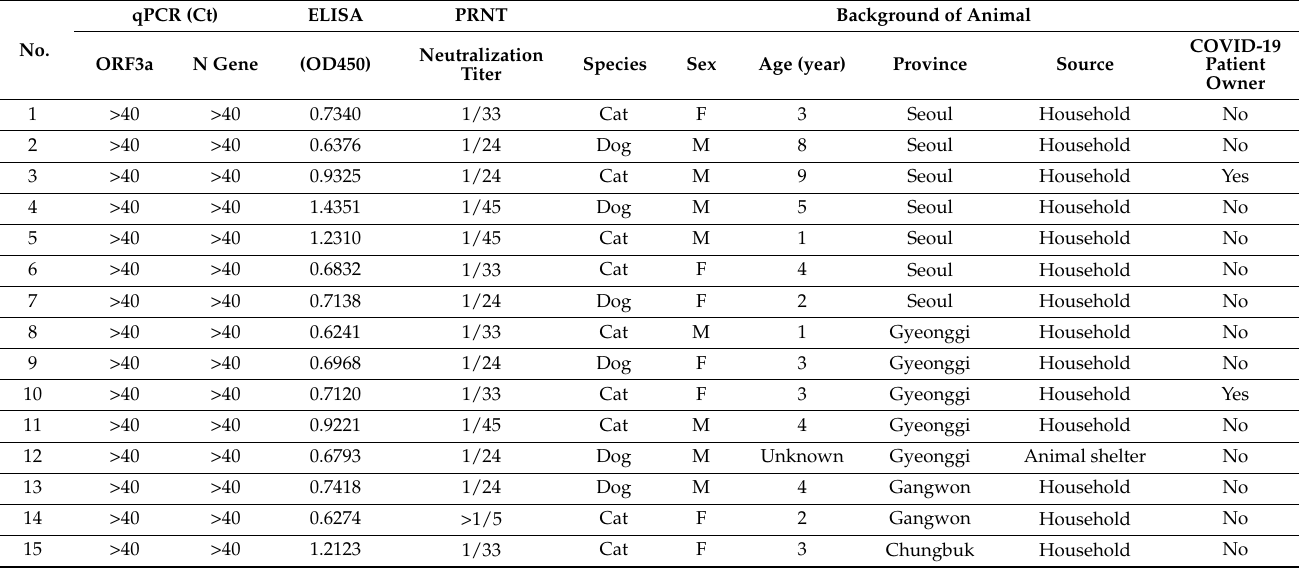
Table 2. Detection of antigens and antibodies against SARS-CoV-2 in dogs and cats by qPCR, ELISA, and